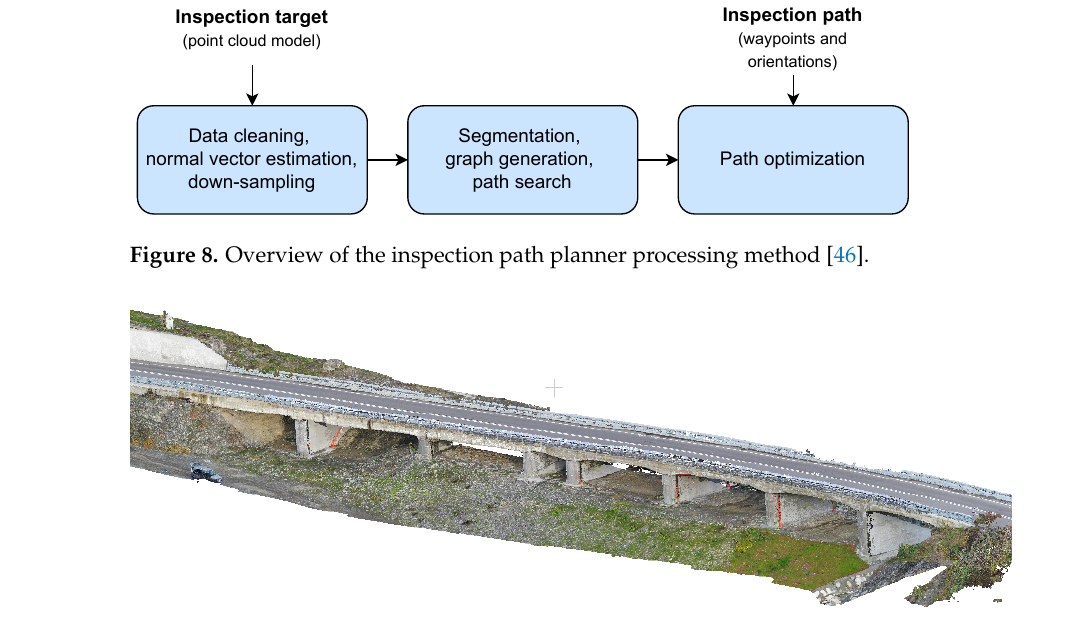
Figure 9. Point cloud of a bridge target for inspection based on a drone preflight test.